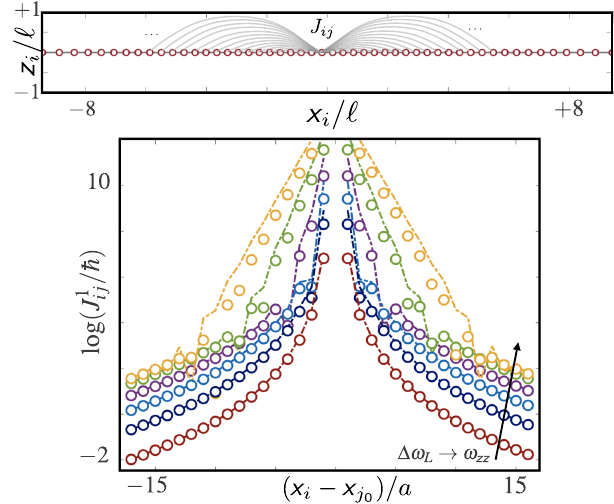
FIG. 6. Trapped-ion chain and effective Ising couplings: (a) equilibrium positions for a chain of N = 50 171 Yb + ions. The gray lines depict the long-range spin-spin couplings J 1 ij between the center-most ion j 0 = N / 2 and the rest of the chain. (b) The exact spin-spin couplings, represented by circles, are cal- (cid:10) = | (cid:21) | 2 E − ω 2 ) ], where [ M i , n M jn /((cid:10)ω 2 culated from J 1 L r z , n ij L n M } N { ω are the eigenvalues and eigenvectors obtained z , n , i , n n = 1 / 2 m from the diagonalization of Eq. (66), and E r = p 2 a is the L recoil energy of the ions due to the beat-note momentum p L = (cid:2) (cid:10) k 171 Yb + ions, the Ising inter- L [205]. We note that for the actions typically use a Mølmer-Sørensen scheme, such that the roles of the X , Z operators must be reversed. The dashed- dotted lines correspond to the coarse-grained predictions of Eq. (104) with no fitting parameter, but directly using the microscopic expressions of all the parameters derived in the main text, and substituting the homogeneous approximation = ia for the inhomogeneous positions of (a). The different x 0 i curves and data correspond to different detunings of the laser beat notes with respect to the zigzag mode (ω zz − (cid:10)ω L )/ 2 π ∈ { 18.75, 37, 5, 93.75, 187.5, 937.5 }